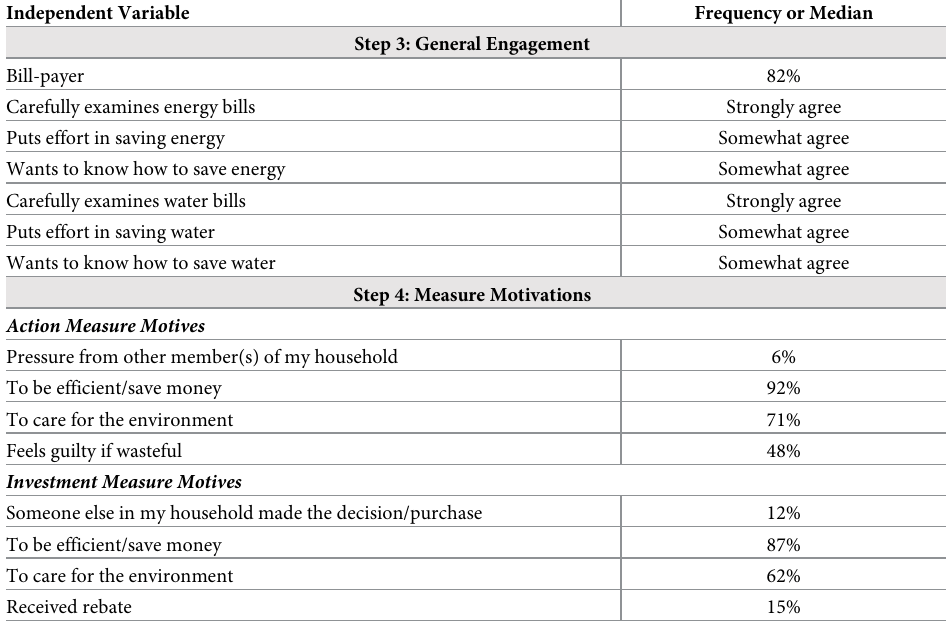
Table 6. Survey sample general engagement and motivations with respect to household water and energy